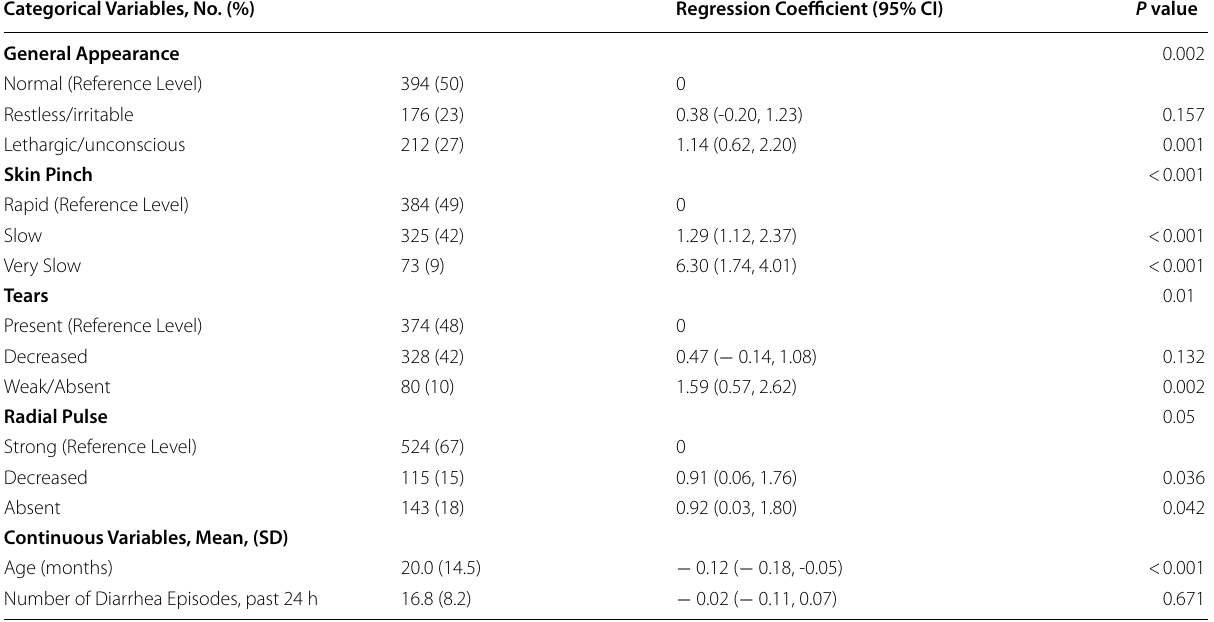
Table 3 Predictors and regression coefficients in the DHAKA model Categorical Variables, No. (%)